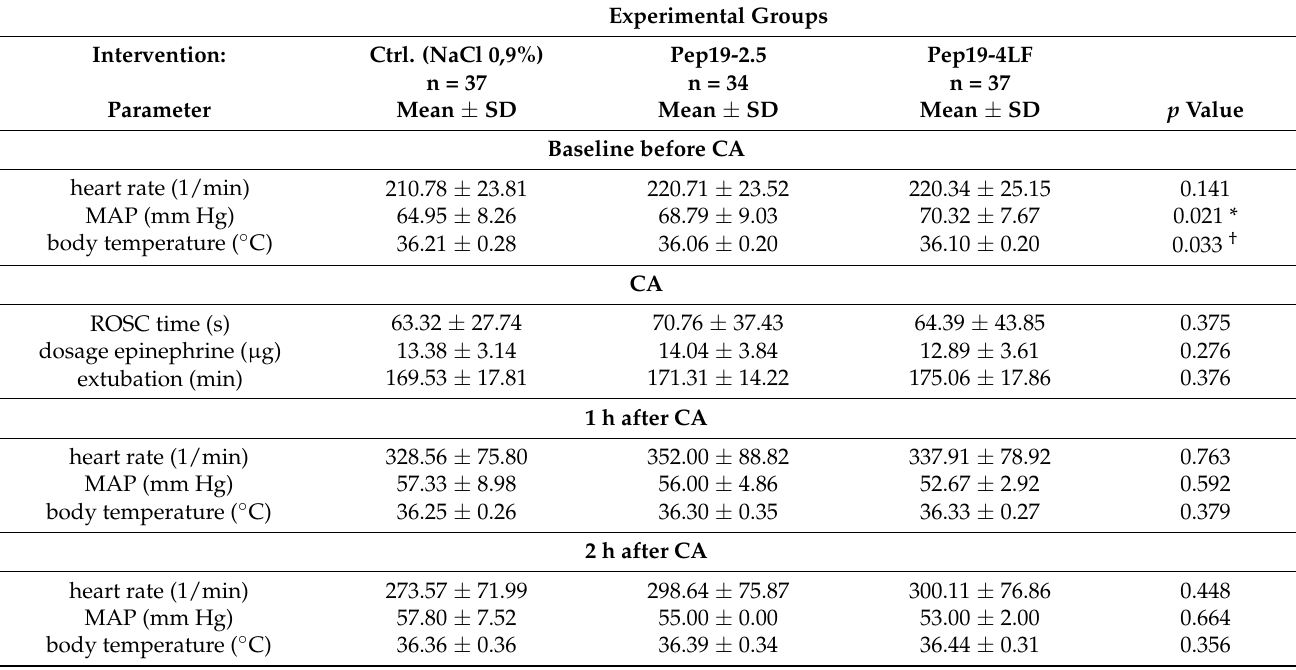
Table 1. Global parameters of CA-CPR. The significance levels were calculated using the Kruskal– Wallis